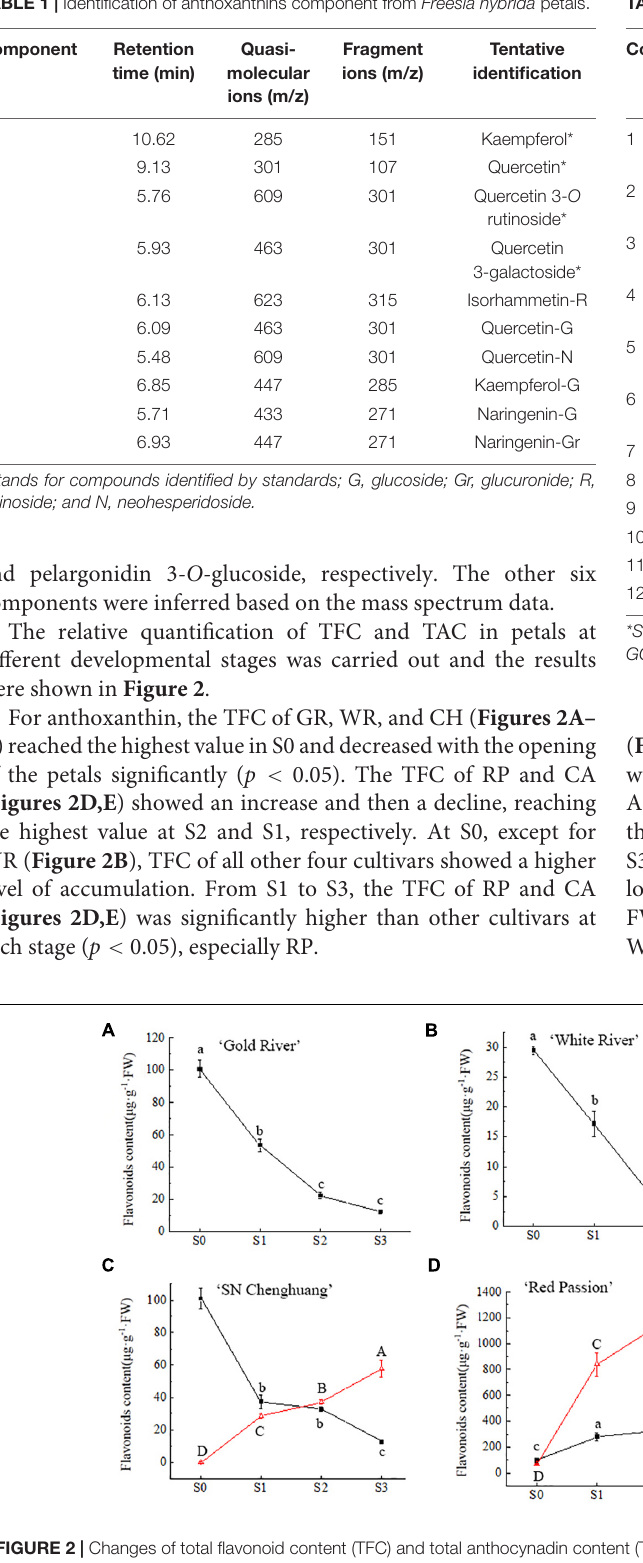
FIGURE 2 | Changes of total flavonoid content (TFC) and total anthocynadin content (TAC) in four flower developing stages of ‘Gold River’ (A) , ‘White River’ (B) , ‘SN Chenghuang’ (C) , ‘Red Passion’ (D) , and ‘Castor’ (E) petals. Uppercase and lowercase letters stand for significance of TAC and TFC in different stages, respectively. The significance of difference is at 0.05 level measured by using the Duncan